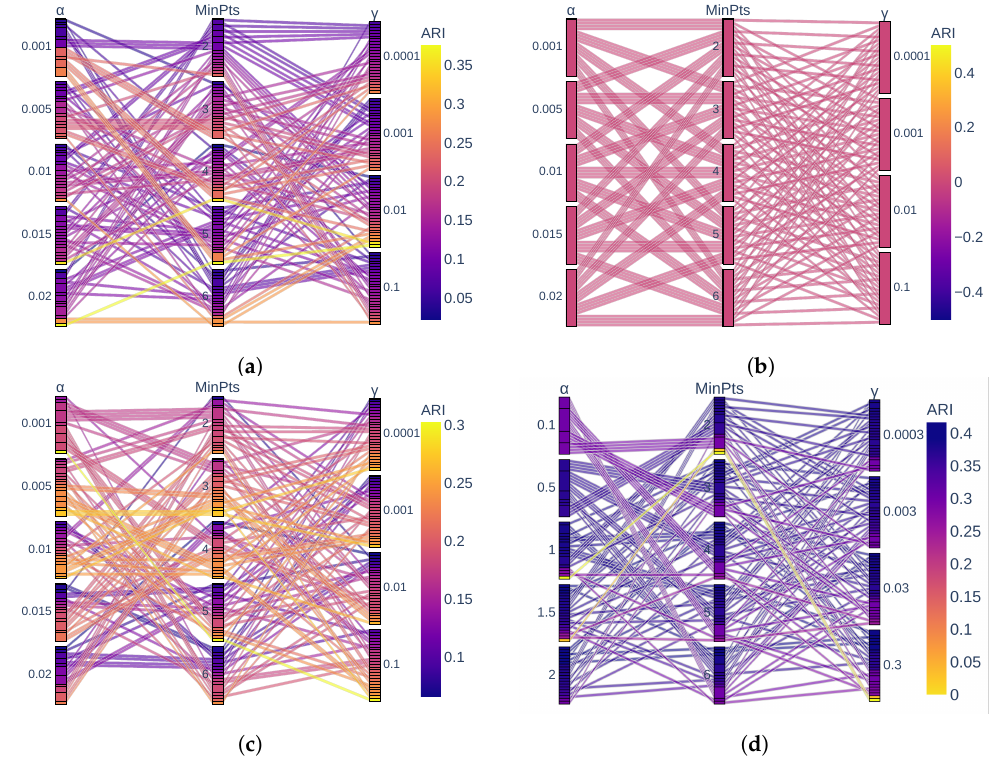
Figure 15. Variation of SOStream hyperparameters and ARI metric values. ( a ) Clustering with the Horseshoe dataset; ( b ) Clustering with the T dataset; ( c ) Clustering with the Moon dataset; ( d ) Clustering with the Three Spirals